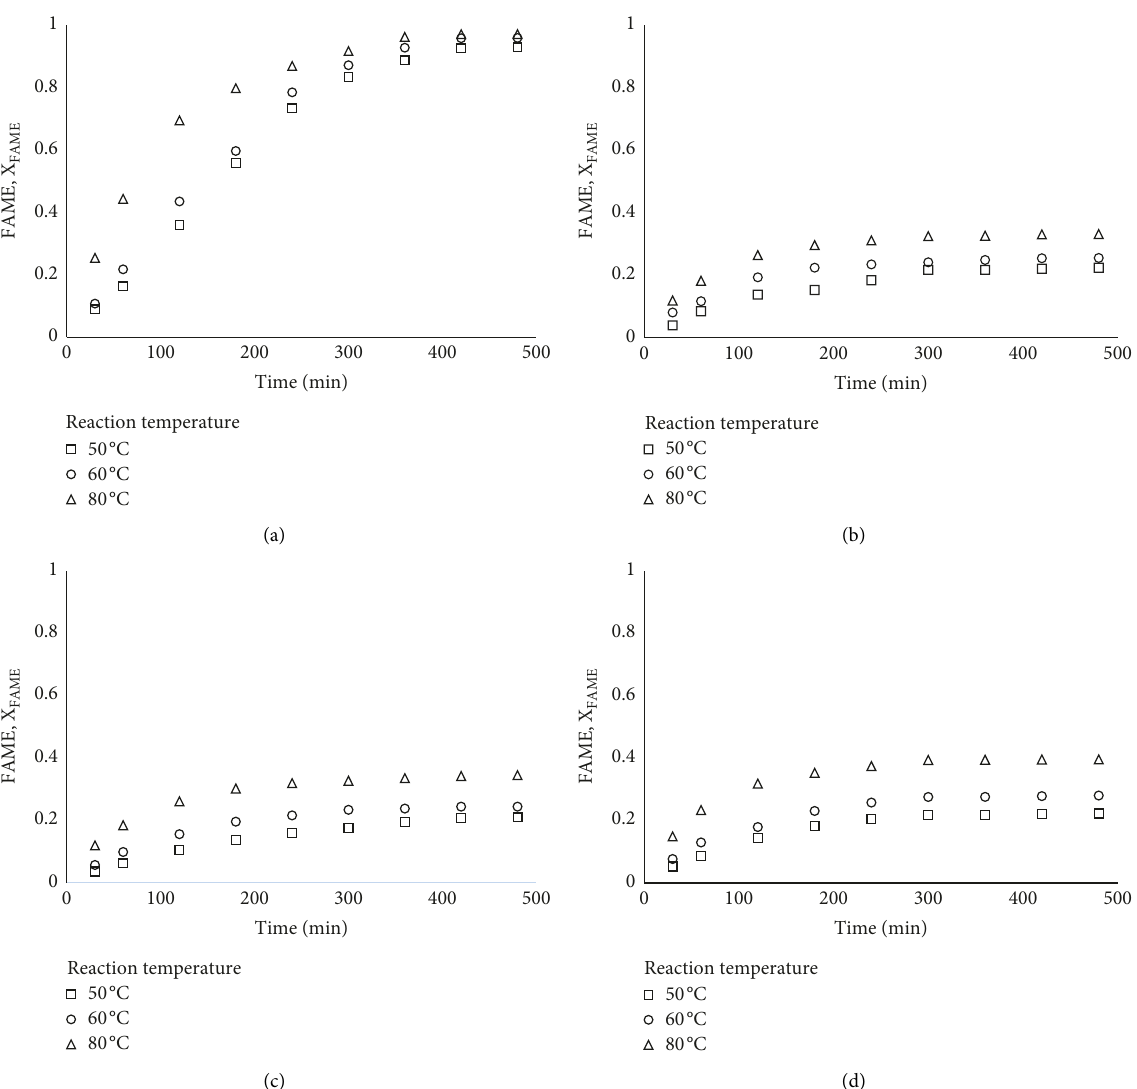
Figure 7: Kinetics of transesterification of safflower oil with methanol using the best alkaline and acidic heterogeneous catalysts. Samples: (a) 3K, (b) 3CA, (c) 3TA, and (d)